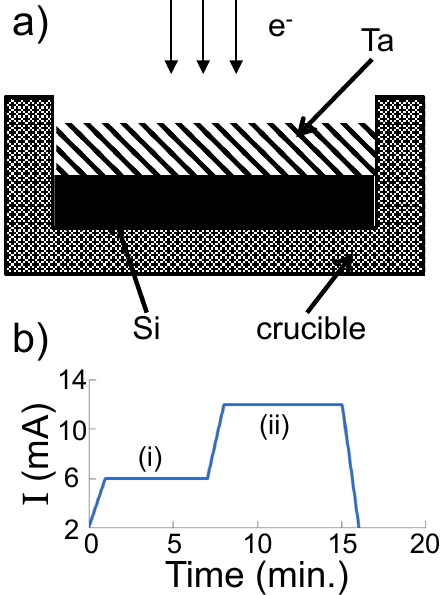
Figure 5. ( a ) Schematic of the Ta and Si arrangement in a graphite crucible before electron beam irradiation; ( b ) Dependence of the electron beam current on time. The materials in the crucible are melted in region (i) and evaporated in region